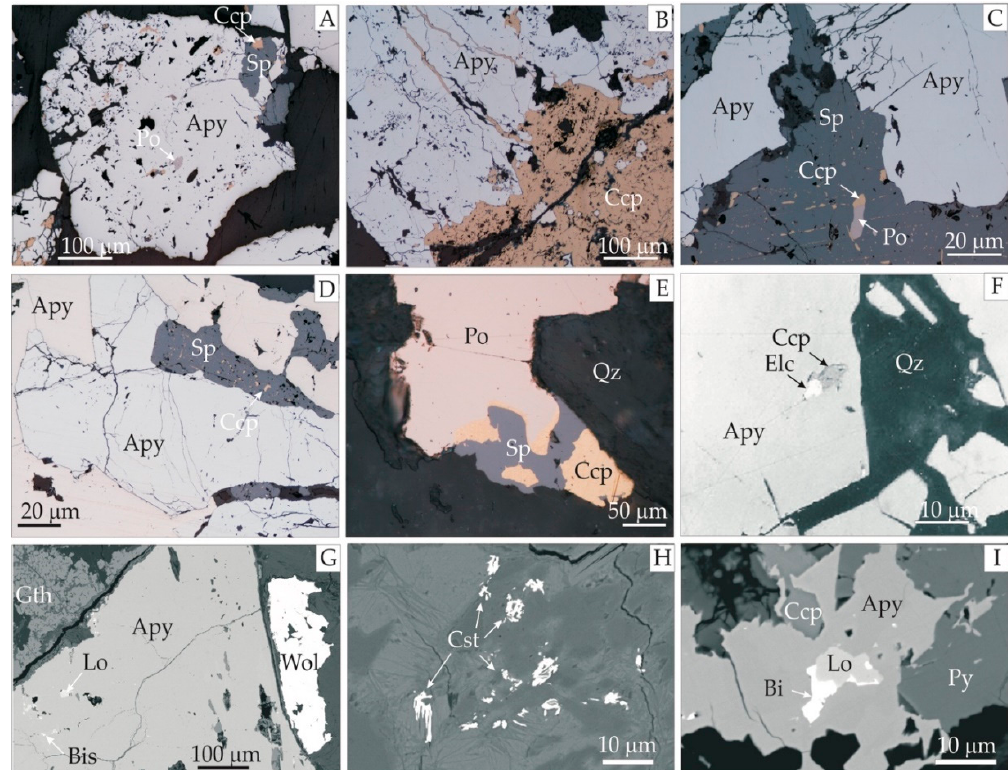
Figure 4. ( A – F ) Photomicrographs under reflected light of ore mineralization from the Miedzianka Cu(-U) deposit. ( A ) Characteristic poikilitic texture of arsenopyrite (Apy) and rare inclusions of pyrrhotite (Po) and ore-free minerals and sphalerite overgrowths (Sp); ( B – D ) Common features of the ore mineralization from the Eastern Karkonosze are fractured arsenopyrite (Apy) aggregates overprinted by base metal sulfides, e.g., mainly by chalcopyrite (Ccp) in association with sphalerite (Sp) and pyrrhotite (Po); ( E ) Overgrowths of pyrrhotite (Po) by chalcopyrite (Ccp) with sphalerite (Sp) and quartz (Qz); ( F ) Fine electrum (Elc) and chalcopyrite (Ccp) intergrowths in fractured arsenopyrite (Apy) massive ore cemented by quartz (Qz); ( G ) wolframite (Wol) (ferberite: WO 3 —77.8 wt.%; FeO—21.2 wt.%; MnO—0.4 wt.%) in association with arsenopyrite (Apy) and goethite (Gth). In arsenopyrite fine inserts of bismuthinite (Bis) and löllingite (Lo); ( H ) disseminated fine xenomorphic crystals of cassiterite (Cst); ( I ) intergrowths of arsenopyrite (Apy) with pyrite (Py) and chalcopyrite (Ccp). Arsenopyrite contains finely disseminated intergrowths of native bismuth (Bi) and löllingite (Lo).